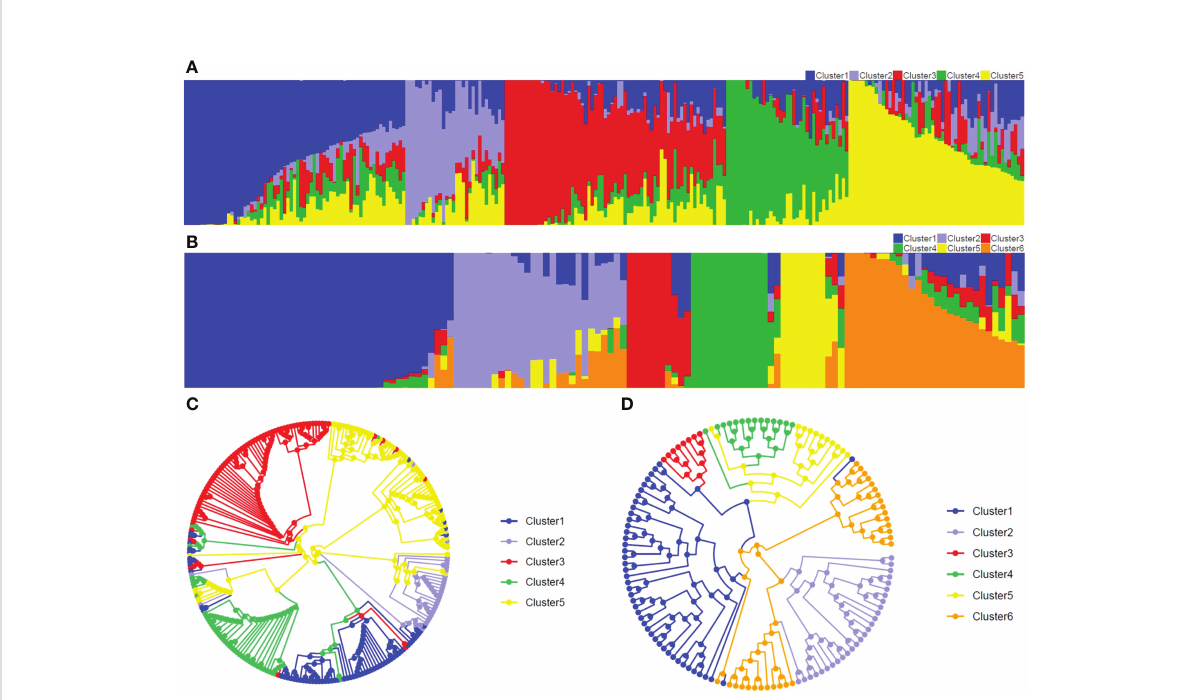
FIGURE 2 Population structure and UPGMA tree in two populations. (A, B) represent population structure in Pop1 ( K =5) and Pop2 ( K =6), respectively. Abscissa and ordinate represent the inbred lines and the membership percentage of inbred line, respectively. (C, D) represent circular UPGMA tree in Pop1 and Pop2,